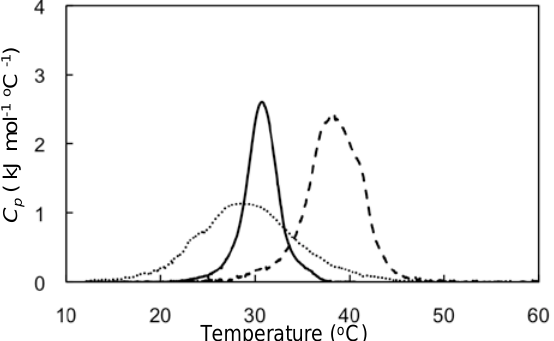
Figure 6. DSC thermograms from aqueous liposomes composed of lipids 1 and 2 at a 5/5 or 2/8 molar ratio (dotted and dashed line, respectively) with no polymer and their 9/1 (v/v) mixture with PVSK (solid line). Concentrations in mM: [ 1 ]+[ 2 ], 1.0 and [PVSK], 0.80 (per monomer unit).